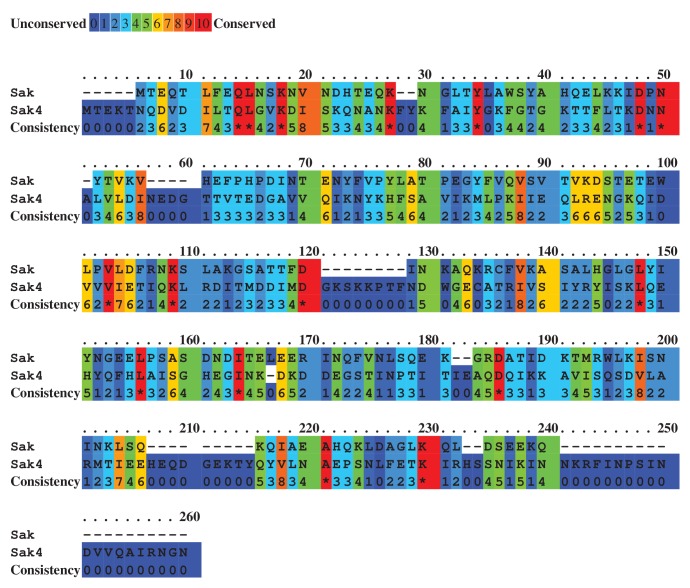
Alignment of predicted Sak (80α) and Sak4 (ϕ52A) staphylococcal phage SSAPs.Colours indicate relative sequence conservation at each position, with red being most conserved and violet being least (adapted from alignment generated by PRALINE).